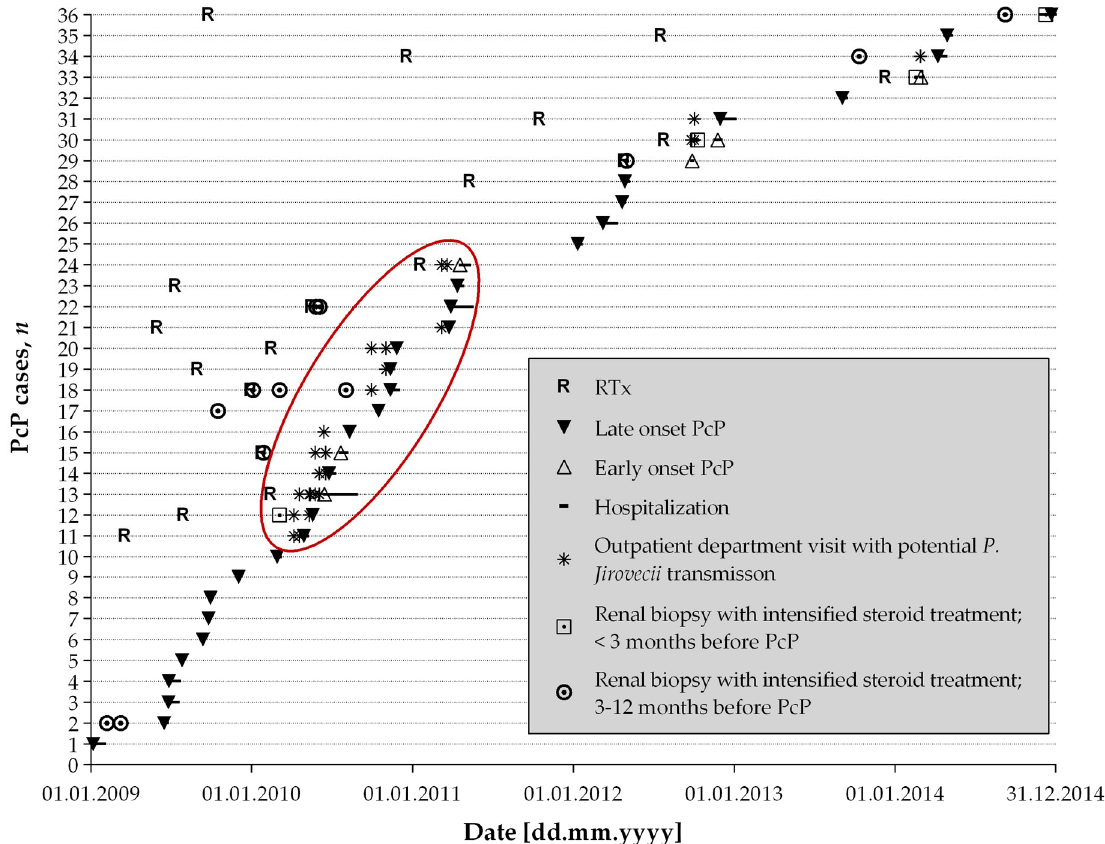
Figure 2. Map of 36 Pneumocystis jirovecii pneumonia (PcP) cases. RTx: renal transplantation. The x -axis reflects the timeline and the y -axis corresponds to the 36 individual cases sorted by time of PcP diagnosis. The red circle marks a potential PcP cluster with closely sequenced PcP cases and potential transmission events with concurrent visits to the outpatient clinic.